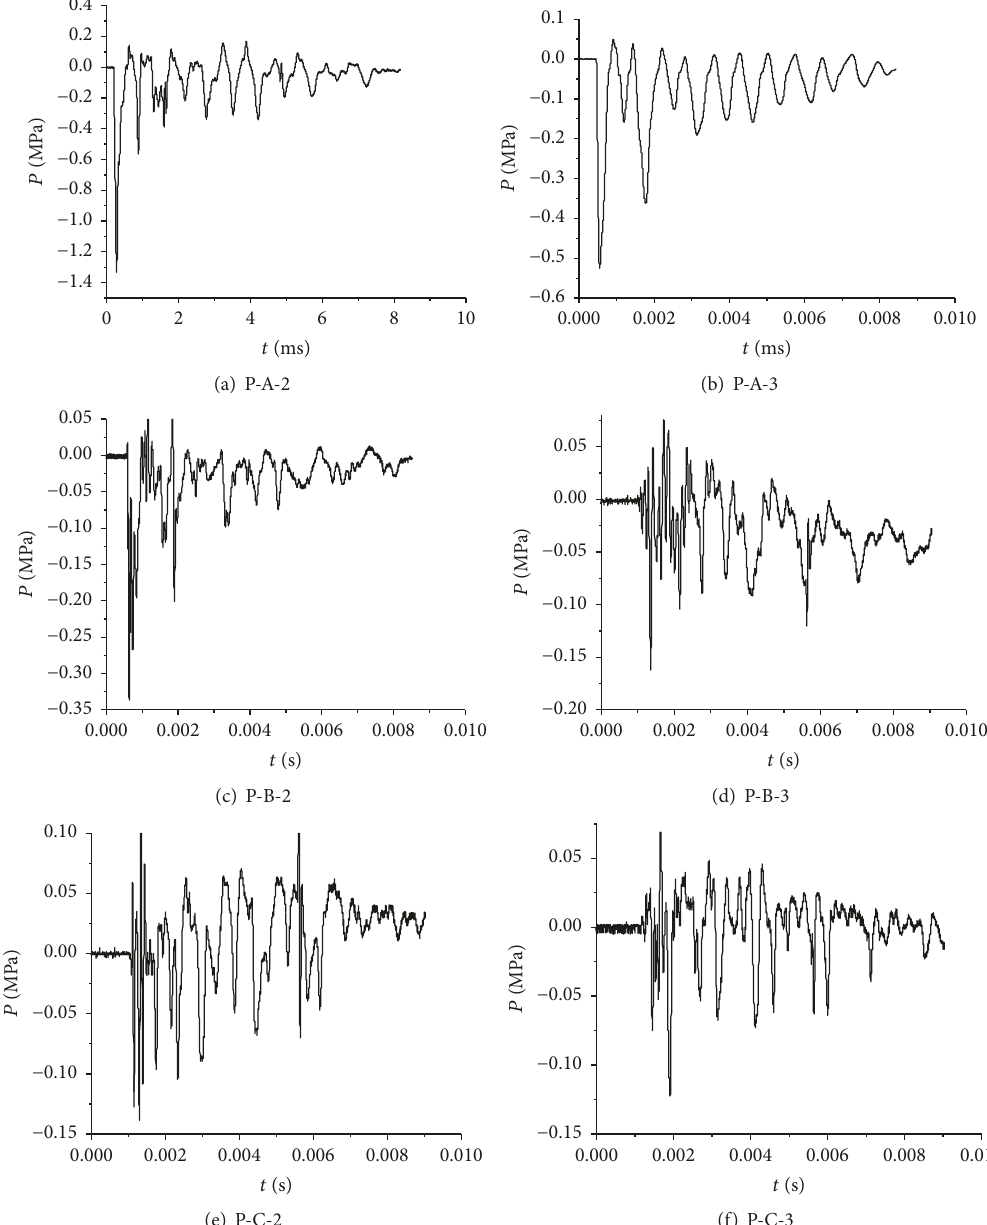
Figure 28: The contact pressure wave of two adjacent layers of Model 2 with an explosive charge quantity of 0.8